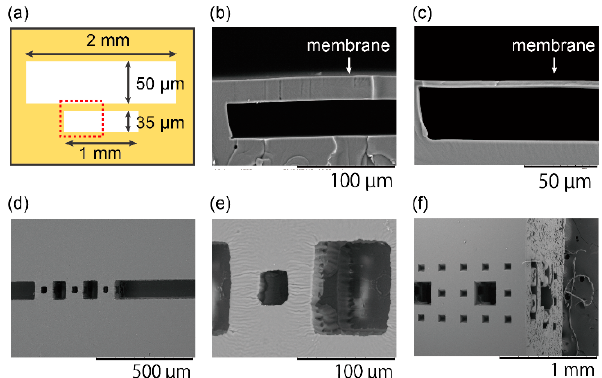
Figure 2. Structures for characterization. ( a ) A schematic illustration of a structure for layer thickness characterization. A red dotted box shows a region for close-up views in ( b , c ). ( b ) An SEM image of a membrane made by a PDMS mold with a thickness of 50 µ m and ( c ) a membrane made by a PDMS mold with a thickness of 4 µ m. ( d ) 90- µ m level-1 Menger sponges; ( e ) A close up image of the level-1 Menger sponge. ( f ) 810- µ m level-2 Menger sponges from oblique view points.